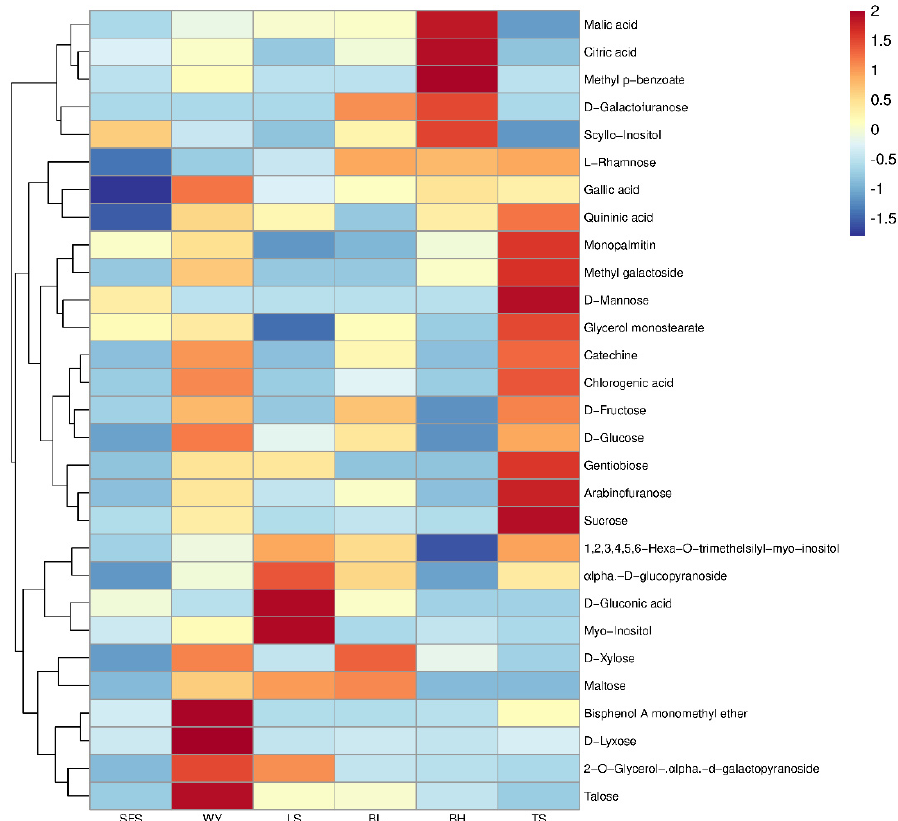
Figure 3. Distribution of primary metabolites at different latitudes of T. amurensis . Heat map visualization of the relative difference of potential biomarkers at different latitudes of T. amurensis . Data of the content value of each compound were normalized to complete linkage hierarchical clustering. Red indicates high abundance, whereas low relative compounds are blue (color key scale above heat map).